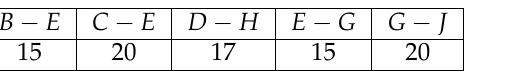
Figure 5. Benefit of transporting a package between two points of the road that directly connect cities i and j , which is represented as i − j